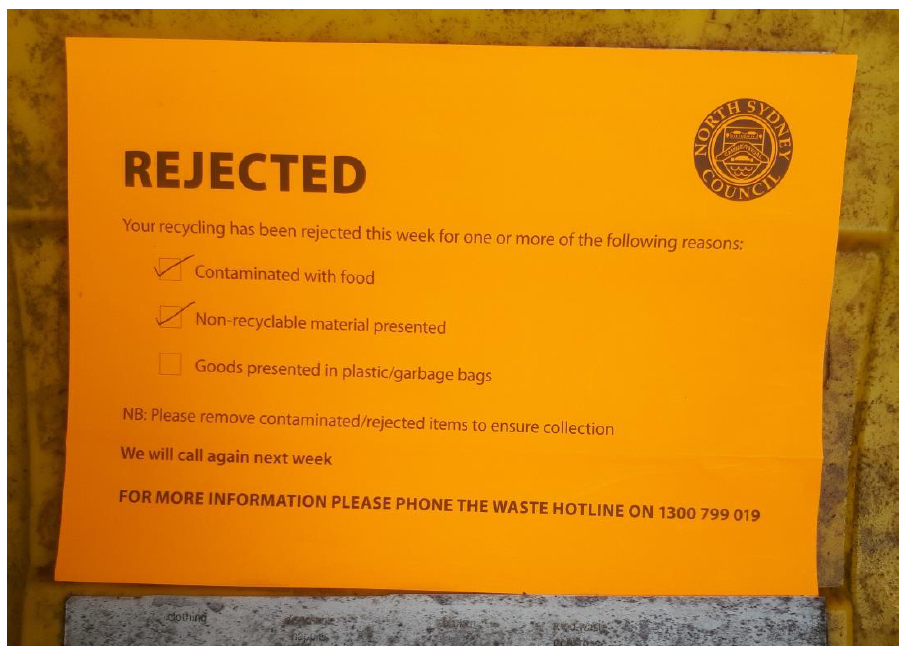
Figure 5. Co-mingled recycling bin in North Sydney, Australia, rejected due to contamination with soft plastics and food (Source: authors).